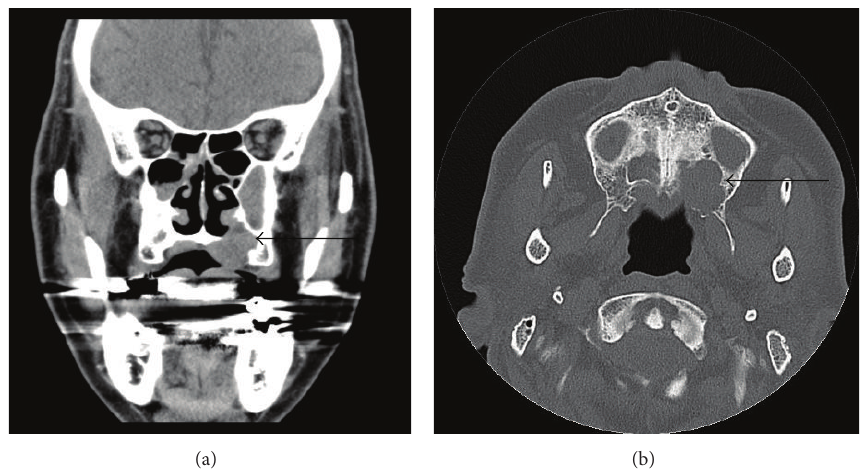
Figure 2: CT images. (a) Frontal plane CE-CT image showing the presence of a 1.8 × 1.4cm mass in the left hard palate, which extended upward and invaded the nasal cavity (arrow). (b) Horizontal image showing hyperplasia localized in bone (arrow) observed upward and backward to the maxillary sinus. No bone destruction was observed.